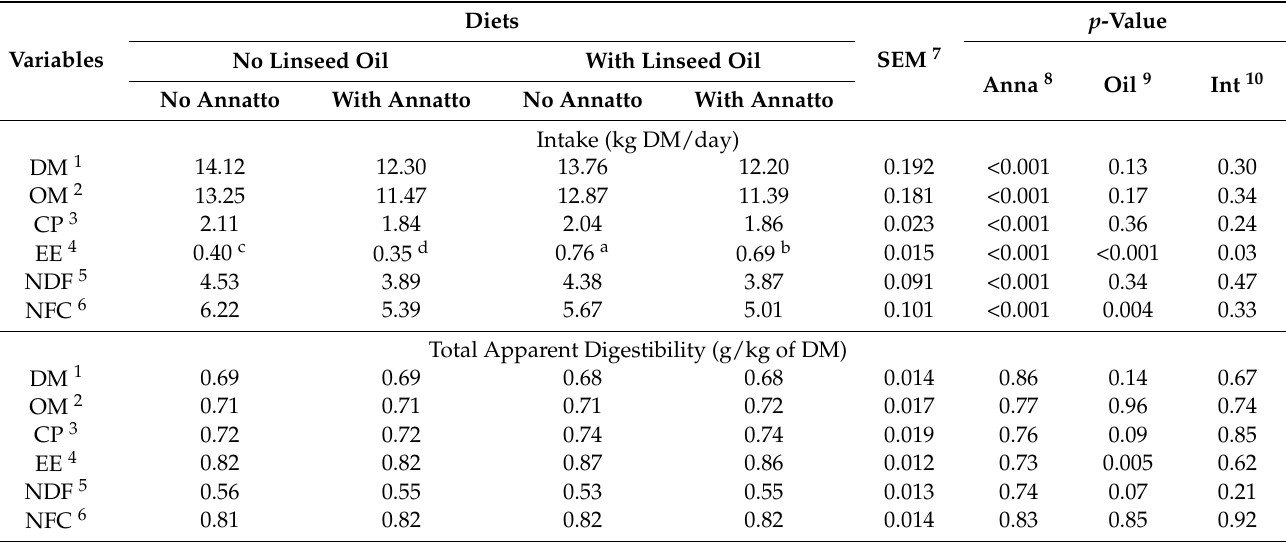
Table 2. Dry matter and nutrients intake and digestibility of Holstein cows fed diets containing annatto seeds and/or linseed